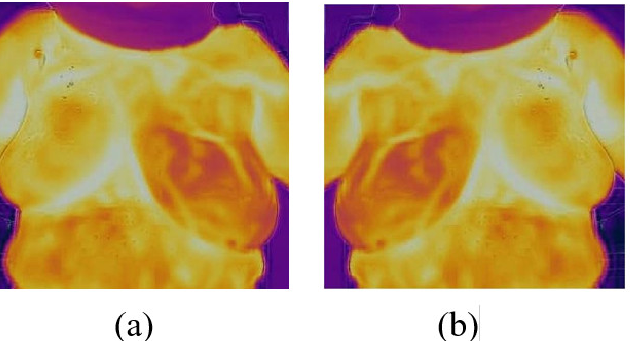
Figure 11. ( a ) Original Thermal Image from Shiraz Medical Center for Breast Cancer & ( b ) Flipped Thermal Image.